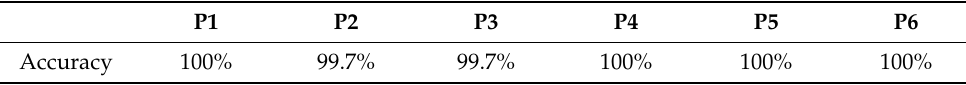
Table 5. Activity monitoring accuracies for six participants.